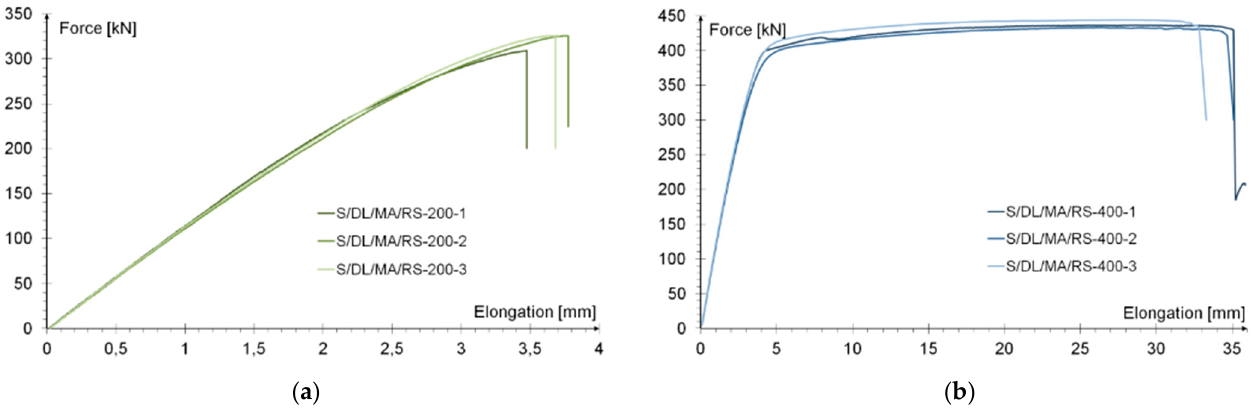
Figure 9. Load-elongation relationship in ( a ) specimens with an effective anchorage length of 200 mm; ( b ) specimens with an effective anchorage length of 400 mm.